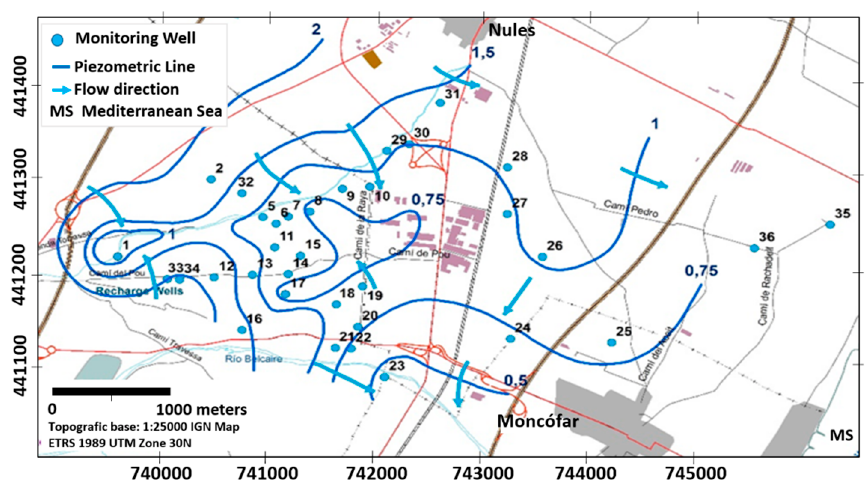
Figure 2. Piezometric map of the Rambleta area, October 2012 (modified from [40]).